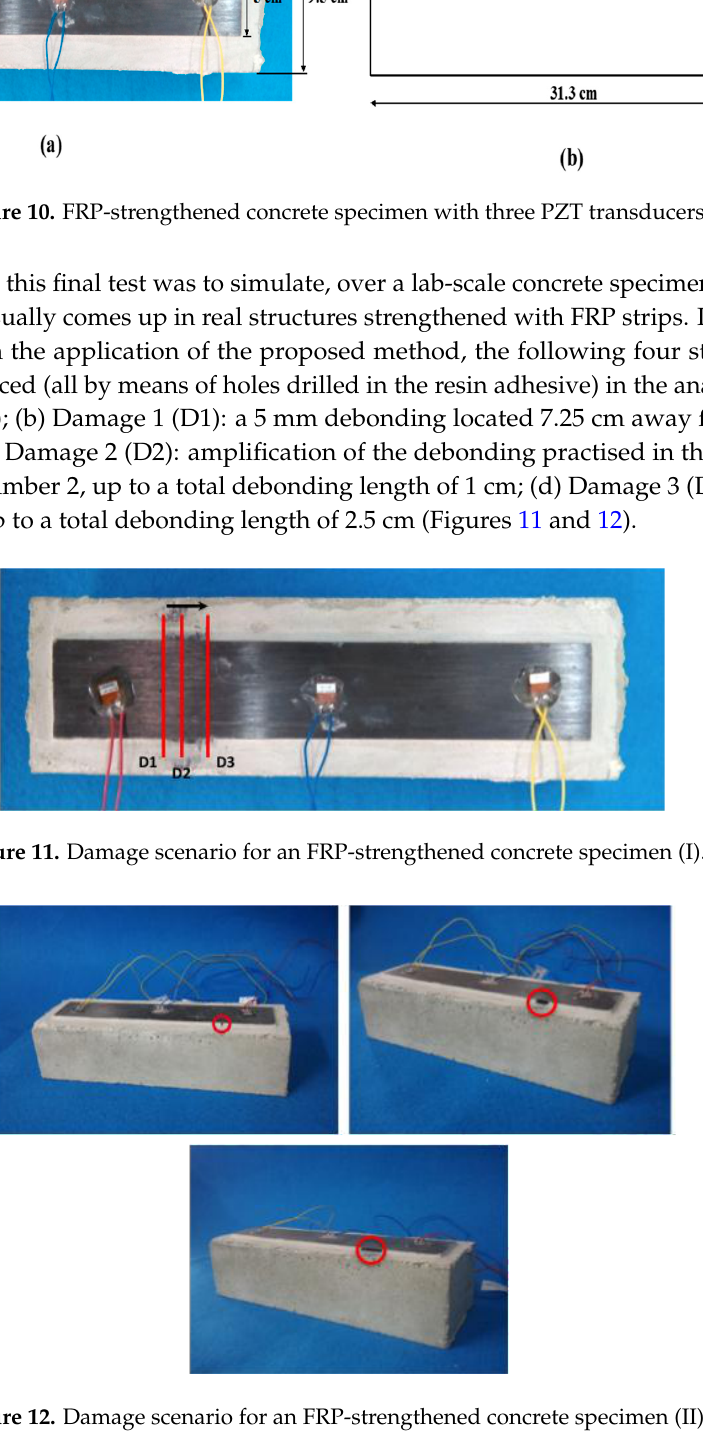
Figure 12. Damage scenario for an FRP-strengthened concrete specimen (II).